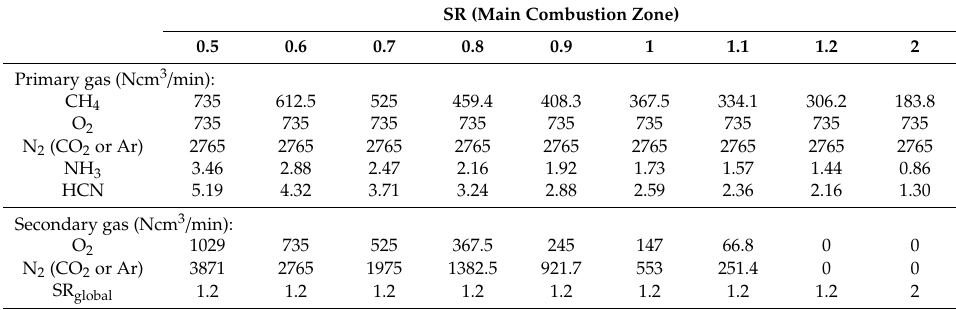
Table 1. Simulation conditions for staged combustion in the tandem-type tube